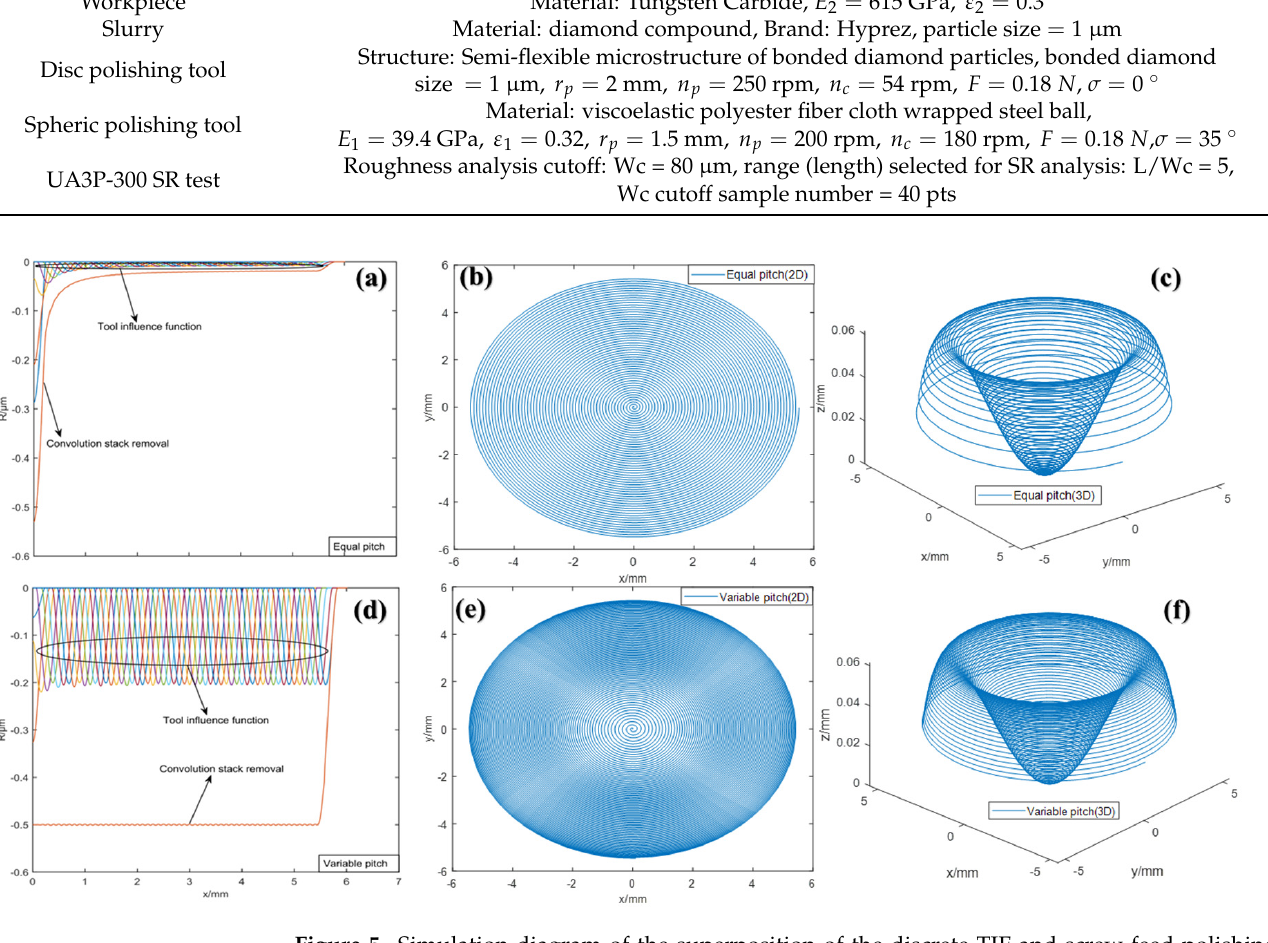
Table 1. Polishing and test conditions.